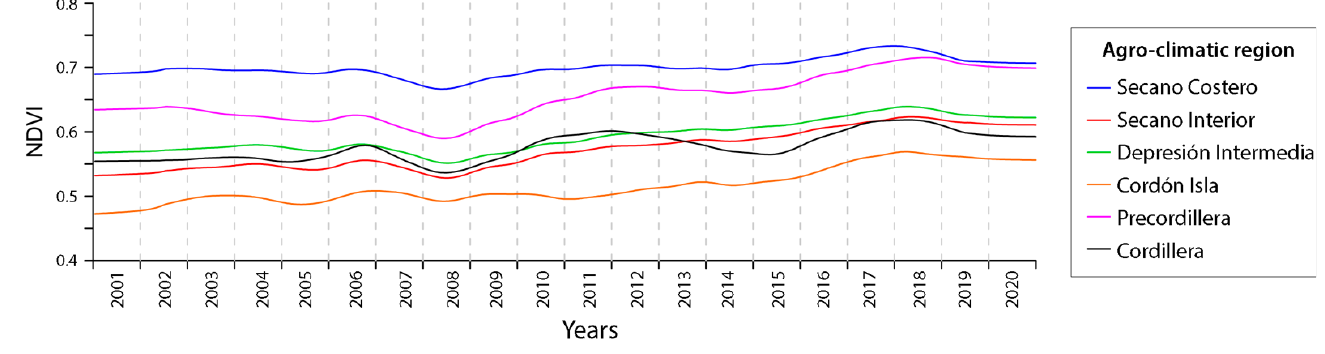
Figure 6. Trends of NDVI over 2001–2020 for each agro-climatic region of Biobio. Figure 7 represents the trends of phenological markers: SOS (Figure 7a), EOS (Figure 7b), the peak of the season (Figure 7c) and NDVI (Figure 7d) over time during the 2001–2020 period. In general, the trend changes in grassland phenology at the peak of maximum NDVI and its value in the period 2001–2020 are more pronounced than SOS and EOS. In the Secano Costero region, the temporal relationships between SOS (Figure 7(a.1)) and EOS (Figure 7(b.1)) slope negatively, which means both growth periods occur earlier, although the duration of the cycle stays the same. This same behavior appears in the Depresi ó n